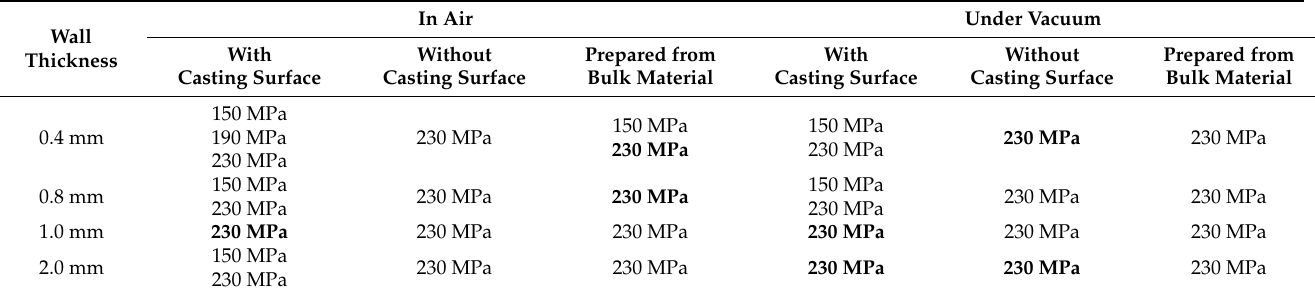
Table 2. Overview of creep tested specimens. Creep tests with conditions highlighted in bold were carried out